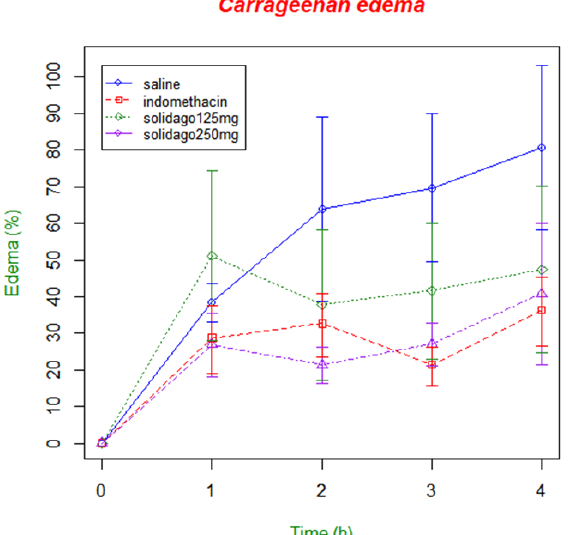
Figure 6 . Variation in paw thickness percent 1 to 4 h after carrageenan administration. Animals were pretreated with vehicle (saline solution + 1% Tween 80, 10 ml/kg), indomethacin 10 mg/kg, S. microglossa extract 125 mg/kg, or S. microglossa extract 250 mg/ kg 30 min before intraplantar injection of carrageenan (300 μg/paw). Edema was measured with a digital caliper at each time point marked. N=7 for all groups. Statistical analyses were performed between the treated groups and the group treated only with the vehicle at certain times (1 h, 2 h, 3 h, and 4 h). Analysis of variance (two-way ANOVA) followed by Tukey’s multiple comparison of the means at the 95% familywise confidence